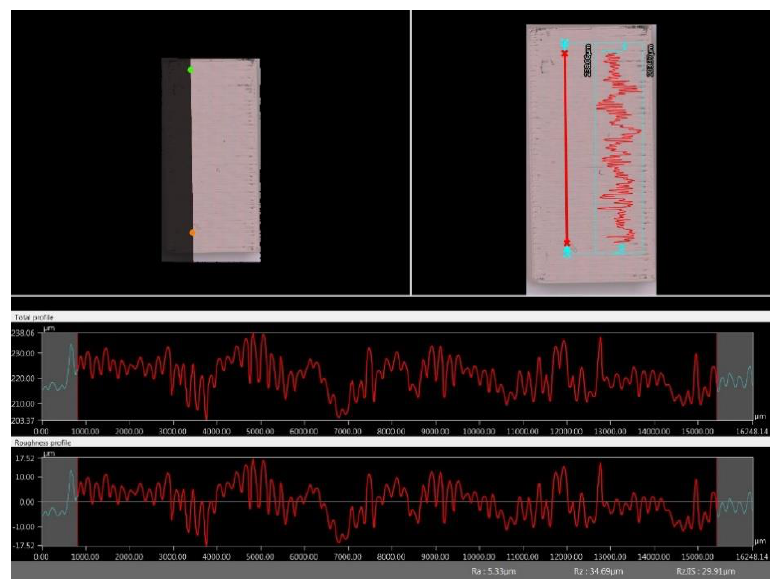
Figure 4. Line roughness measurement for printed composite 50 S sample .